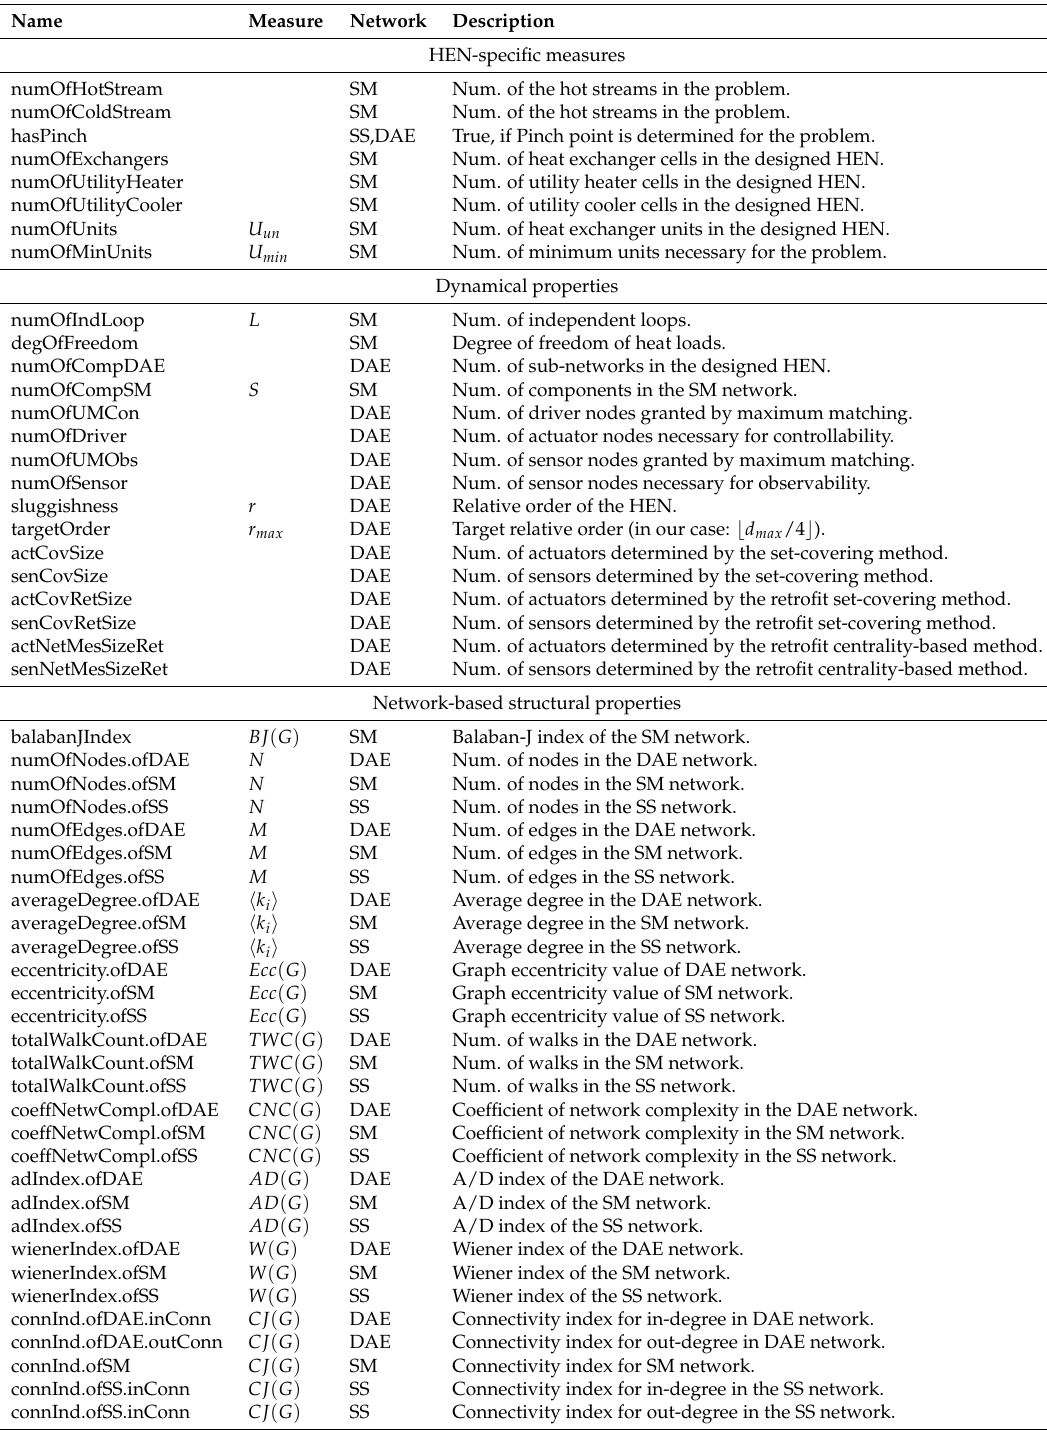
Table 5. Calculated measures and their short